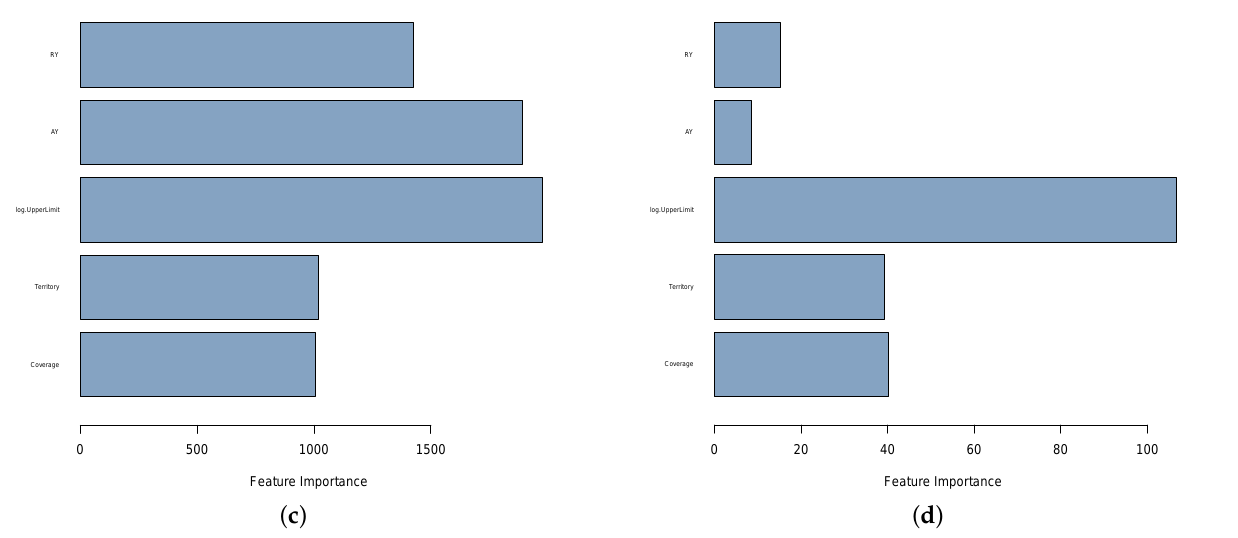
Figure 10. Bar plots for variable importance measures of risk factor in GLM based on the log scale claim counts using our proposed method. (The Poisson error function is with log link function).